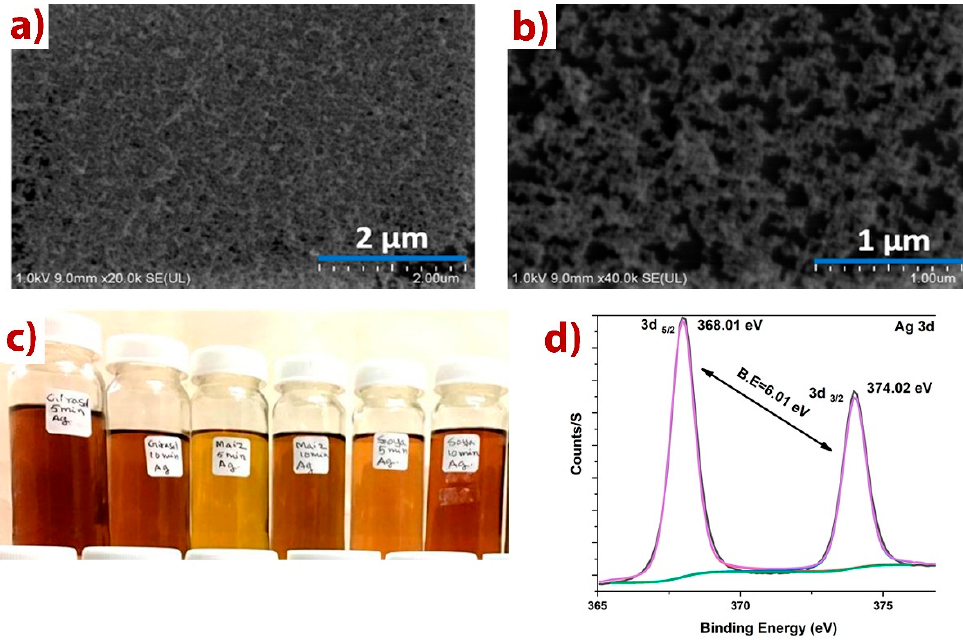
Figure 1. Ag nanostructure morphology by SEM at two different magnifications ( a ) 20,000 ⨉ and ( b ) 40,000 ⨉ . ( c ) Vials with different Ag-based nanofluids at various laser ablation times (5 and 10 min) and ( d ) X-ray photoelectron spectrum of the Ag-nanostructures.